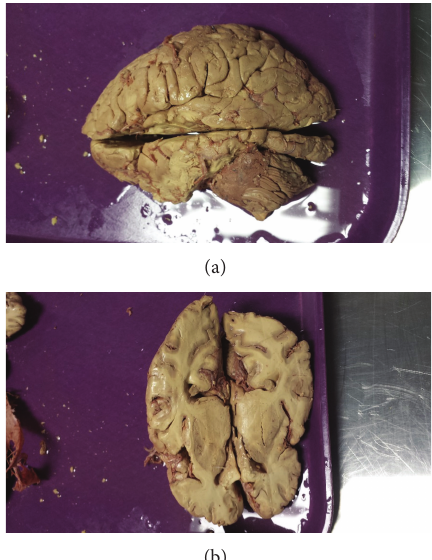
Figure 6: Sagittal dissection of the brain (a) and horizontal dissec- tion of the brain (b). This figure shows absence of inflammation of the brain and the size differences between right and left